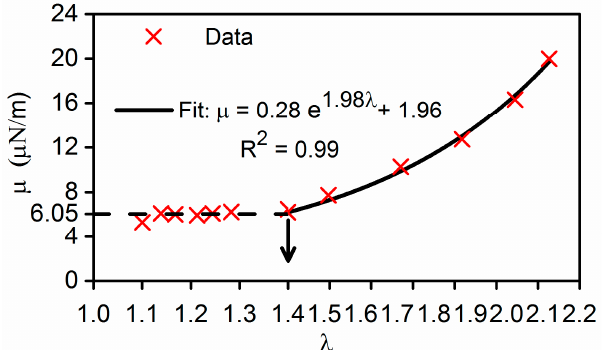
Figure 5. Mean values of membrane shear modulus and best fit functions for nonlinear elastic moduli: for small deformation ( λ < 1.4), membrane shear modulus, µ = 6.05 µN/m; for large deformation ( λ > 1.4), µ = 0.28 × e 1.98 λ + 1.96 .